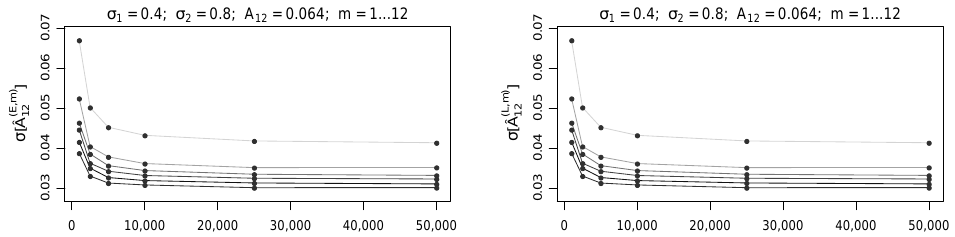
] and σ [ ˆ A ( L , m ) ] as a function of n h . Decreasing m values are considered from darker Figure 4. σ [ ˆ A ( E , m ) 12 12 to brighter